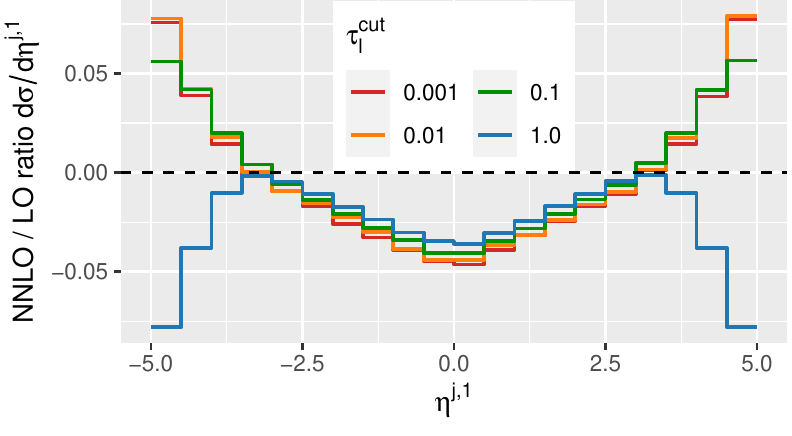
Figure 3 . NNLO corrections from the light-line production vertex for the leading jet pseudorapidity distribution, relative to LO . The τ cut -dependence of the corrections is shown in the range 0 . 001 – 1 . 0 l